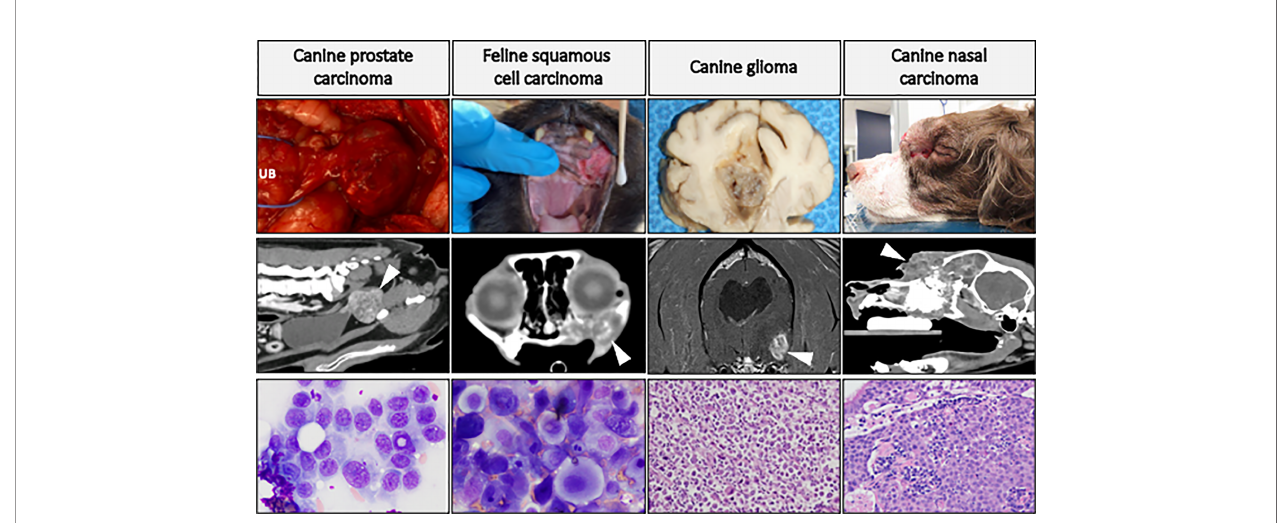
FIGURE 4 | Panel of companion animal tumors that are often treated with radiotherapy. Top row: gross tumor images of canine prostate carcinoma (UB, urinary bladder), glioma, and nasal carcinoma (causing facial deformity), and feline oral squamous cell carcinoma. Middle row: advanced diagnostic imaging of respective cancer types (CT images, except for glioma which is MRI) with white arrows directed at tumor tissue. Bottom row: cytologic preparations (Wright-Giemsa) of canine prostate carcinoma and feline oral squamous cell carcinoma; histologic (H&E) images of canine glioma (high-grade astrocytoma) and canine nasal carcinoma. This is not an exclusive list of cancers with translational potential for radiotherapy